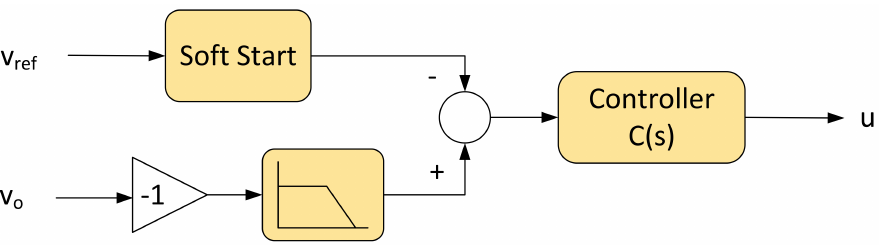
Figure 8. Cuk controller